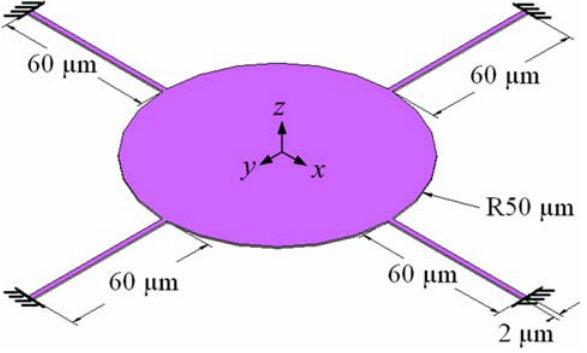
Figure 1. Schematic representation of the micromirror.